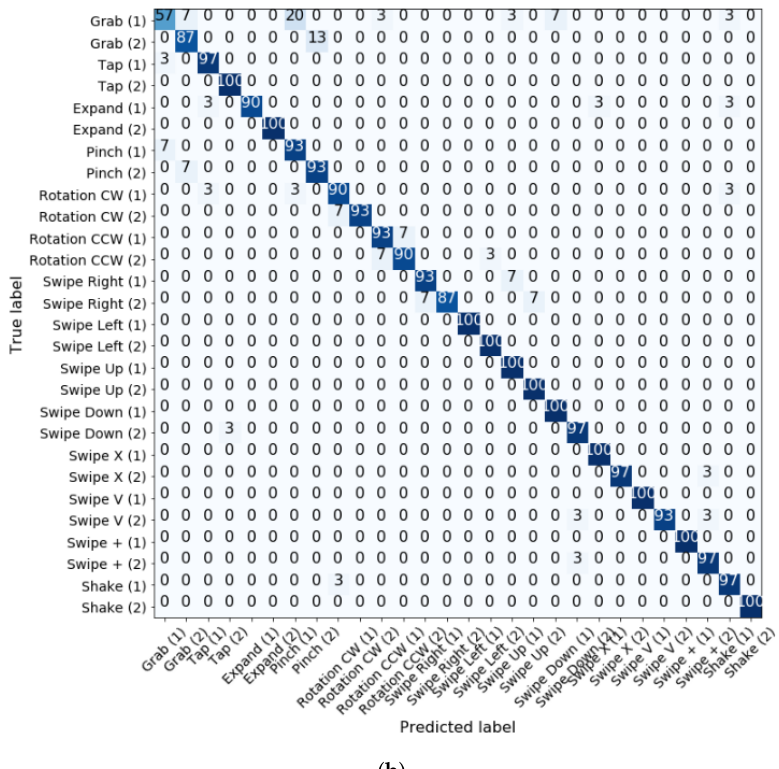
Figure 16. Confusion matrix of the best prediction results using depth + skeleton data: MLF LSTM (accuracy of 96.07%) ( a ) on DHG-14 and (accuracy 92.38%) ( b ) on